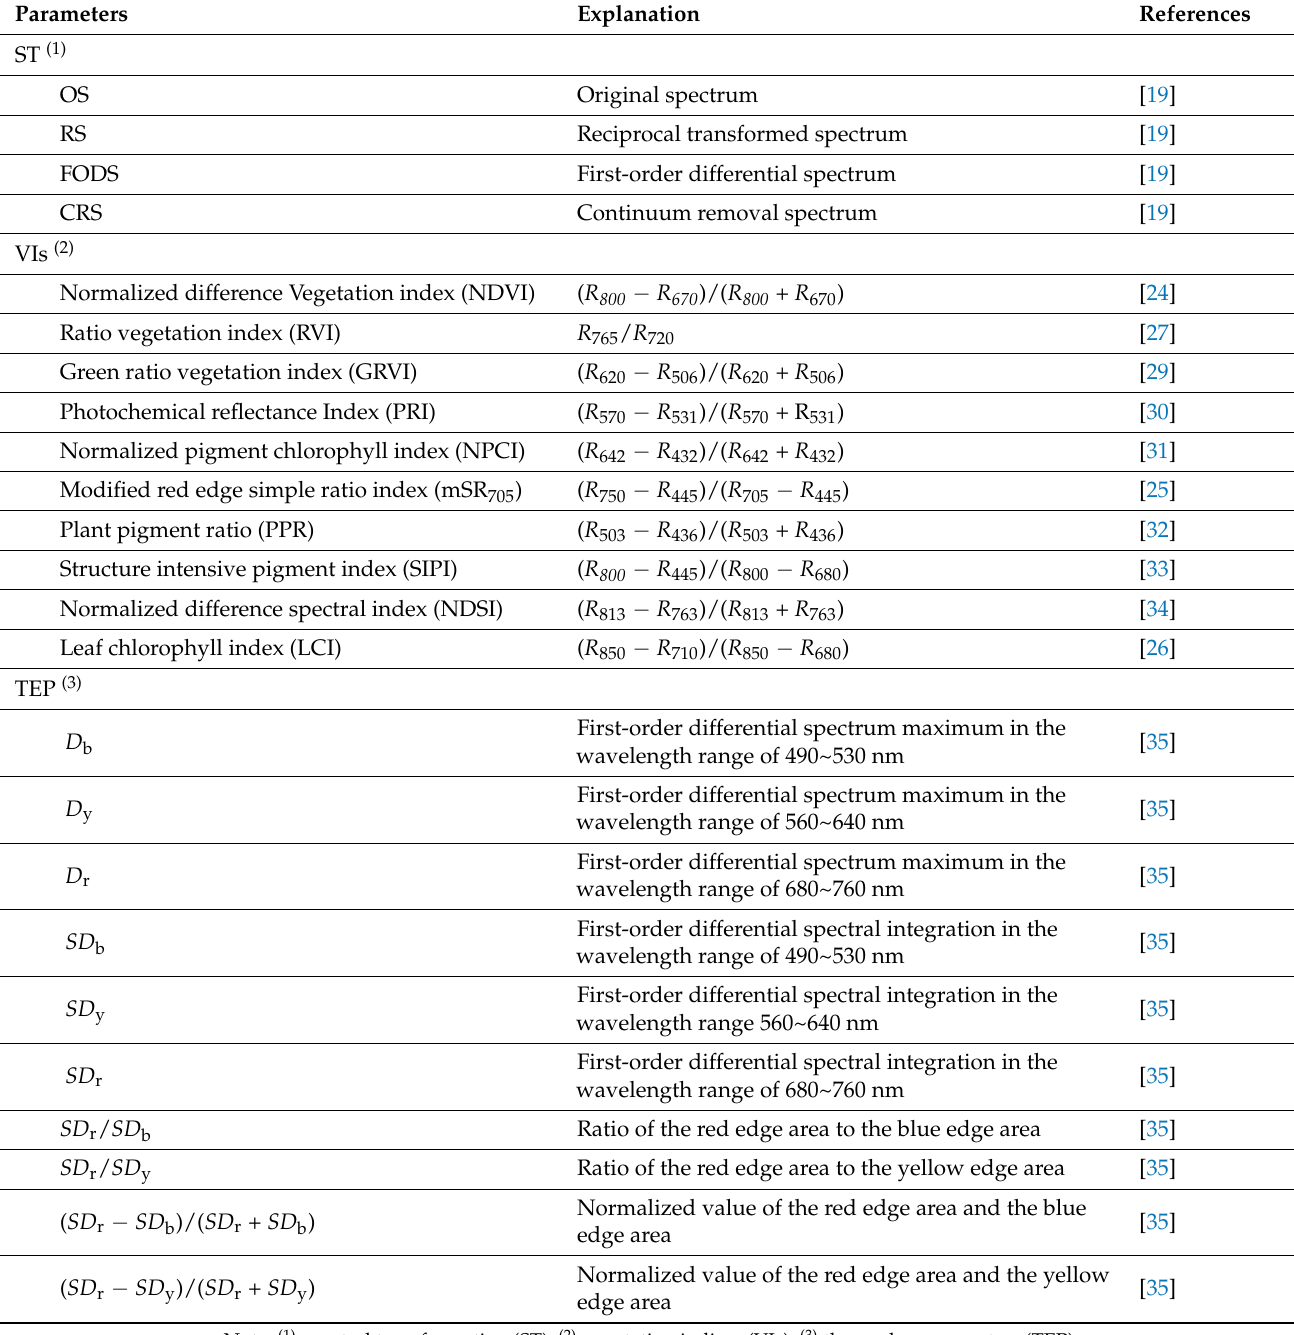
Table 2. Spectral parameters evaluated in this